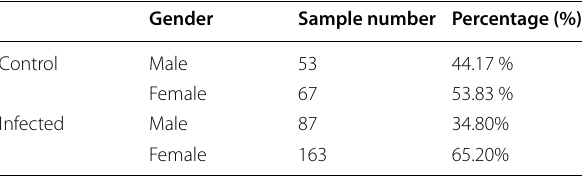
Table 1 Gender profile of patients with recurrent malaria cases